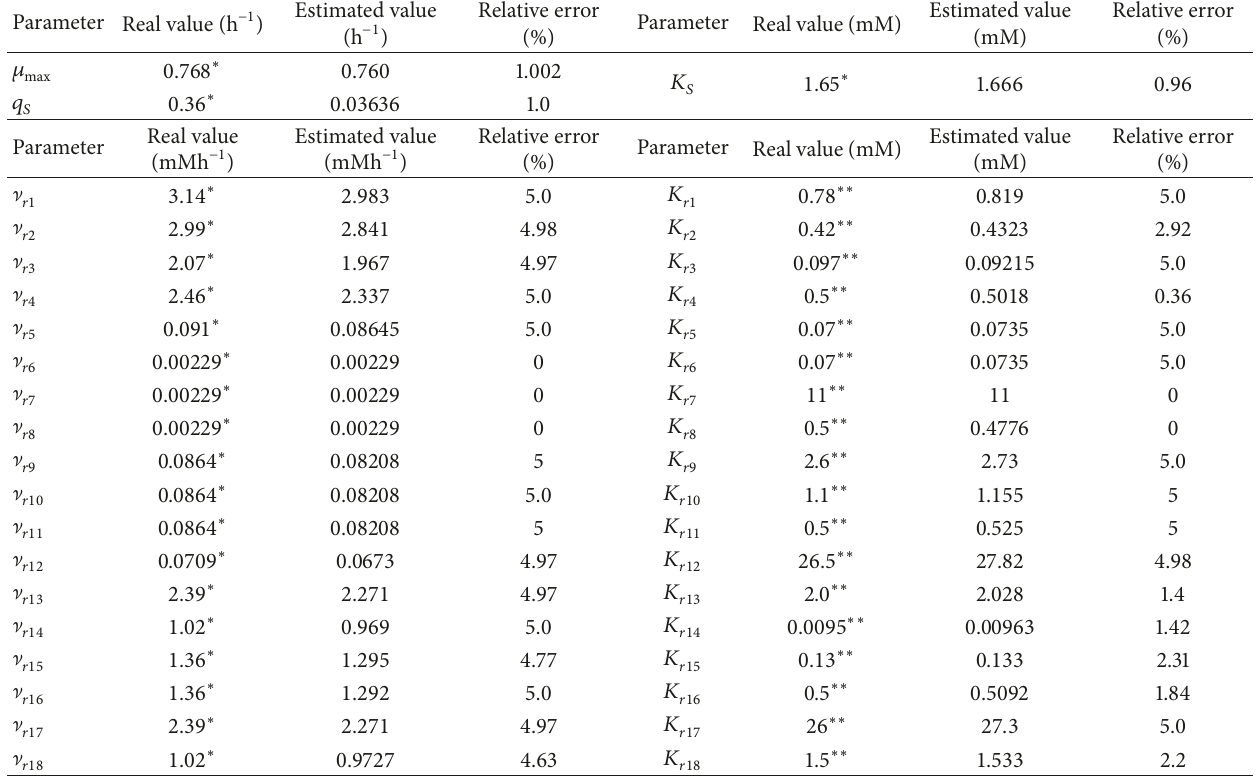
Table 3: Real and estimated parameters and relative error between